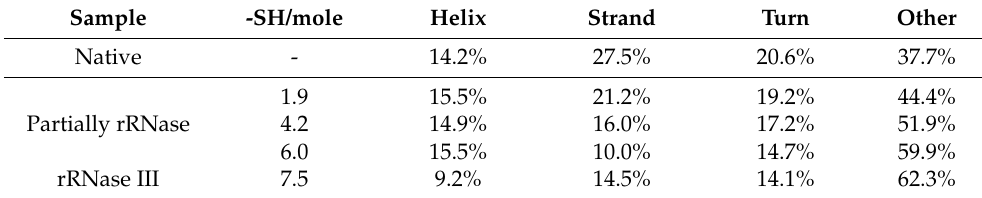
Table 5. Secondary structure analysis of the CD spectra of the reduction